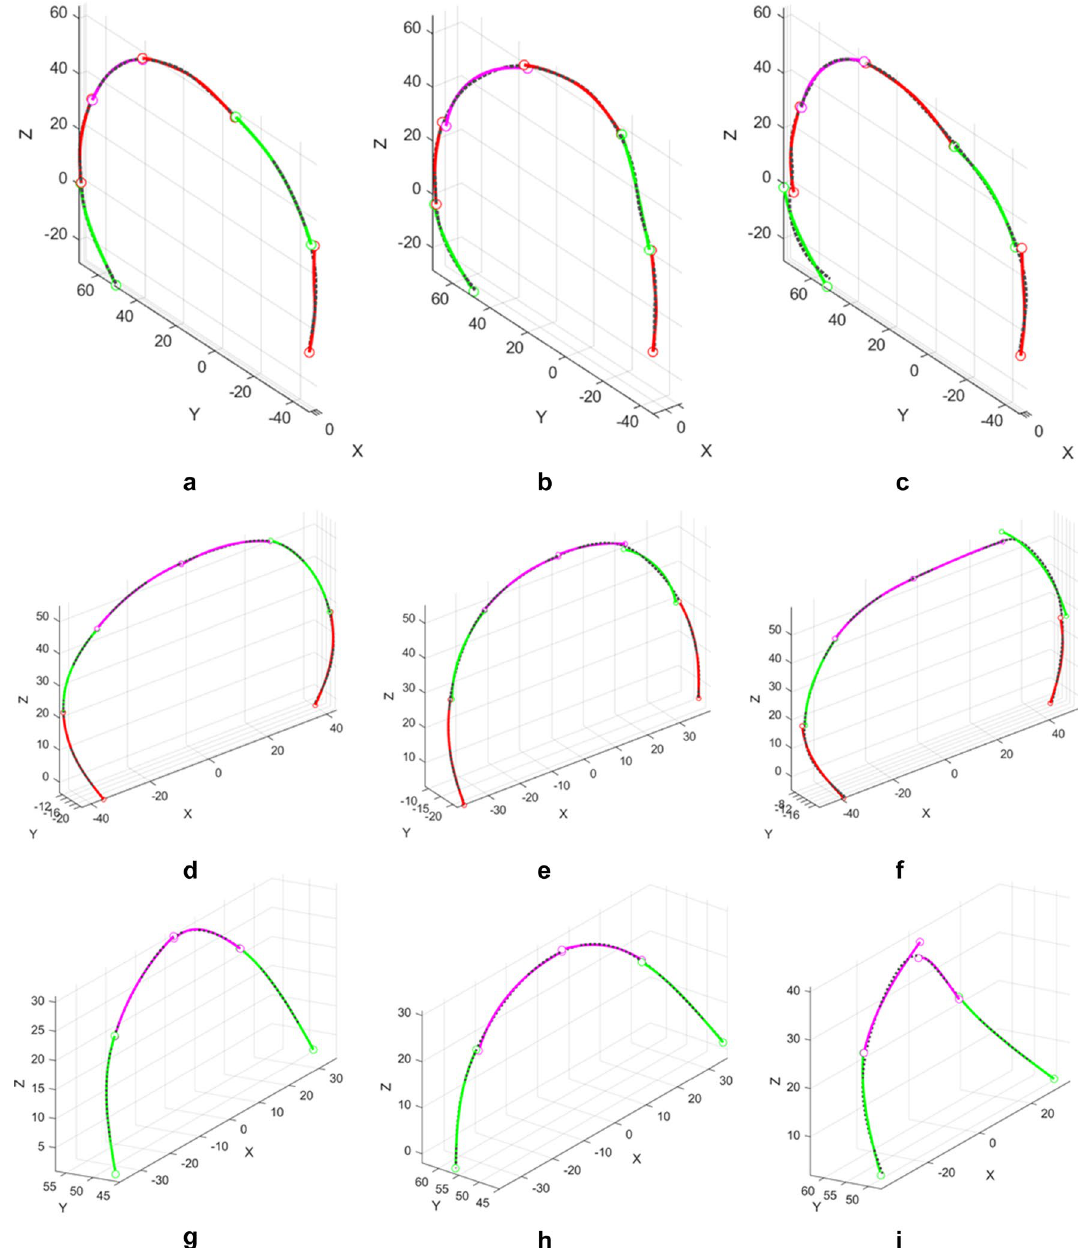
Figure 15. The fitting results of ( a–c ) sagittal curves, ( d–f ) coronal sutures, and ( g–i ) lambdoid sutures from 63 samples. The left column ( a , d , g ) is the best match of each group, the middle column ( b , e , h ) is the average match of each group, and the right column ( c , f , i ) is the worst match of each group. ( a ) E s − 52 = 0.5122 (unaffected); ( b ) E s − 19 = 0.8681 (BCS); ( c ) E s − 46 = 1.6055 (unaffected); ( d ) E c − 12 = 0.2507 (BCS); ( e ) E c − 54 = 0.5082 (unaffected); ( f ) E c − 42 = 0.9636 (RUCS); g E l − 29 = 0.1225 (BCS); ( h ) E l − 37 = 0.3687 (BCS); ( i ) E l − 28 = 1.0997